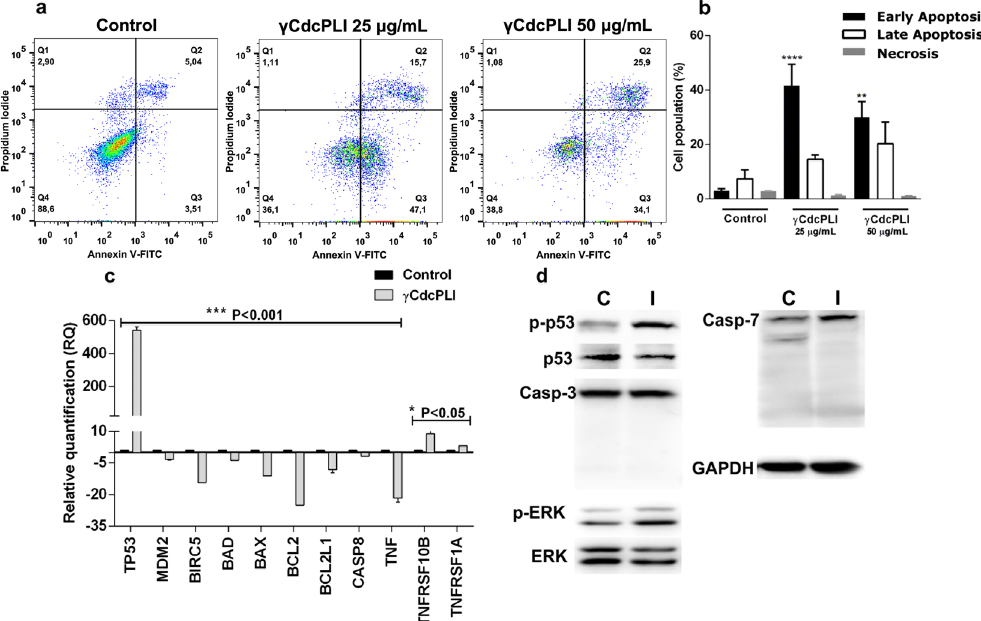
Figure 2. MDA-MB-231 cell death induced by γ CdcPLI. ( a ) Analysis of apoptosis by flow cytometry: The representative dotplot acquisitions revealed apoptotic cells and necrotic areas. ( b ) Analysis of apoptosis by flow cytometry: Bar diagram showed percentage of cells in necrosis, early and late apoptosis. ( c ) Relative quantification of apoptosis pathway genes by real-time PCR (TP53, MDM2, BIRC5, BAD, BAX, BCL2, BCL2L1, TNF, TNFRSF10B, TNFRSF1A, CASP8) in MDA-MB-231 cells 24 h after γ CdcPLI treatment (25 µ g/ml). ( d) Protein expression of many apoptosis-related proteins by Western Blotting (p-Akt, Akt, P-ERK, ERK and the constitutive protein HPRT and GAPDH) in MDA-MB-231 cells treated with γ CdcPLI 25 μ g/mL for 24 h. All data are expressed as mean ± S.E.M and all experiments were carried out in triplicate; differences between treatments and controls were analyzed by One-way, Two-way ANOVA and Unpaired t-test. Statistically